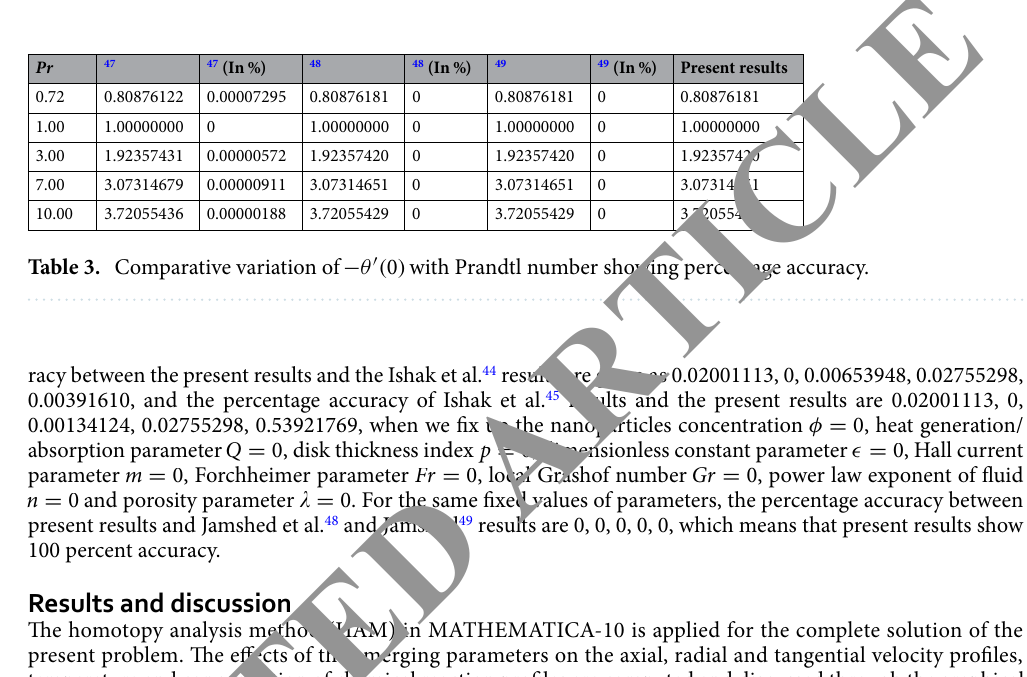
θ ′ ( 0 ) with Prandtl number showing percentage accuracy. −